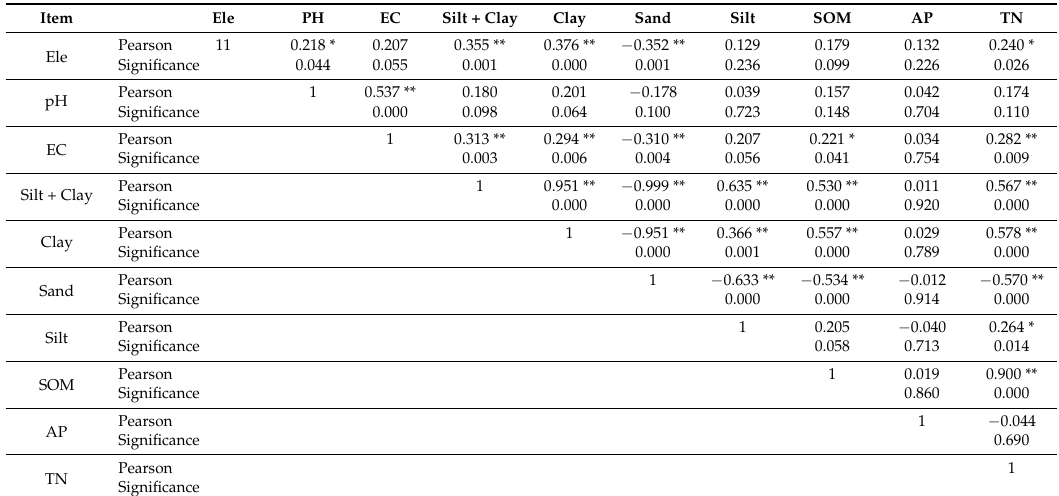
Significance ** Significant correlation at layer 0.01 (double-tailed); * The correlation was significant at 0.05 layers (double-tailed); ‘SOM’ represents soil organic carbon concentration; ‘Clay’ represents the content of soil clay particles; ‘Silt’ represents the content of soil particles; ‘Ele’ represents the altitude; ‘pH’ represents pH of soil. Table 3. Pearson coefficient of soil nutrient and elevation and soil texture in rainy